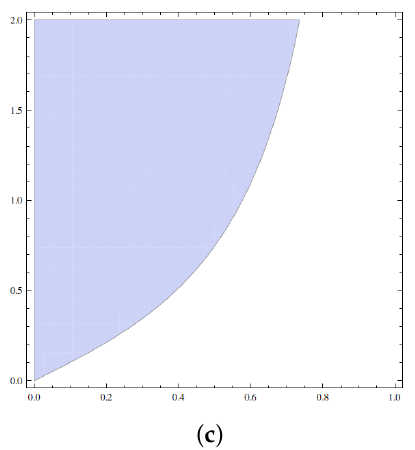
Figure 1. The inequality for specific heat of the Case-I is plotted in ( a ), Case-II is plotted in ( b , c ). Along the abcissa ( X ) we have chosen the value of horizon radius r + and along the ordinate ( Y ) we have chosen the value of q . We have set (cid:96) = χ = 1.